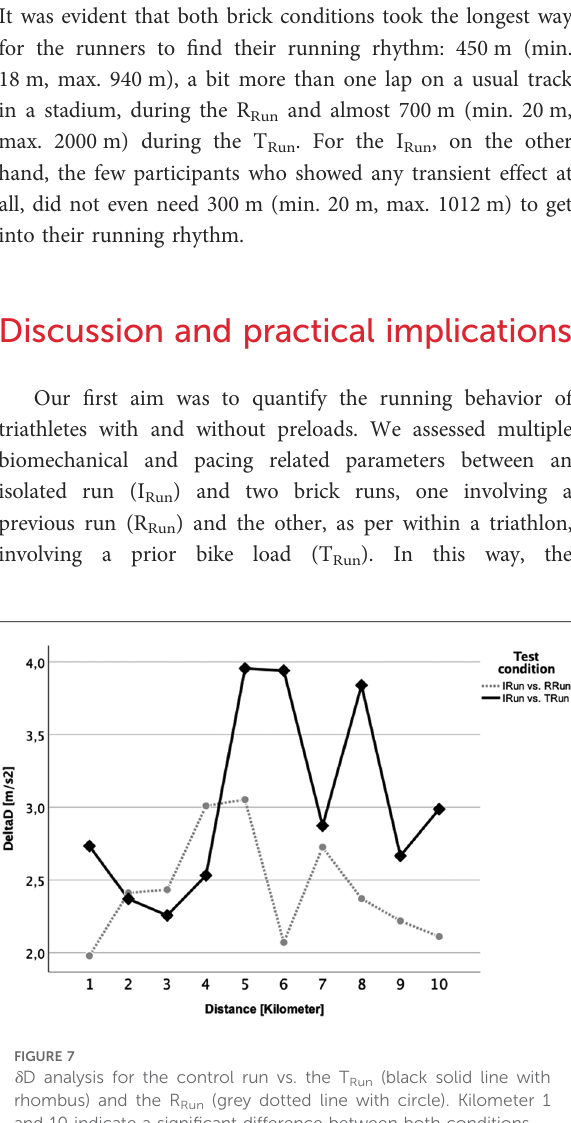
FIGURE 5 Kilometer-separated development of ground contact time between the three running conditions (Triathlon Run=dark grey dotted line; Run Run=black solid line; Isolated Run=grey dashed